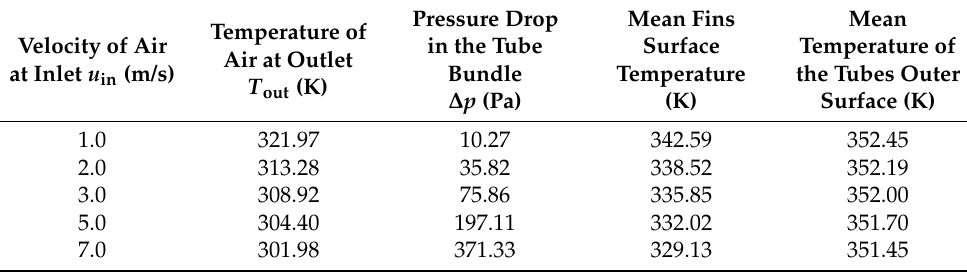
Table 6. Output data for the star-shaped fins without